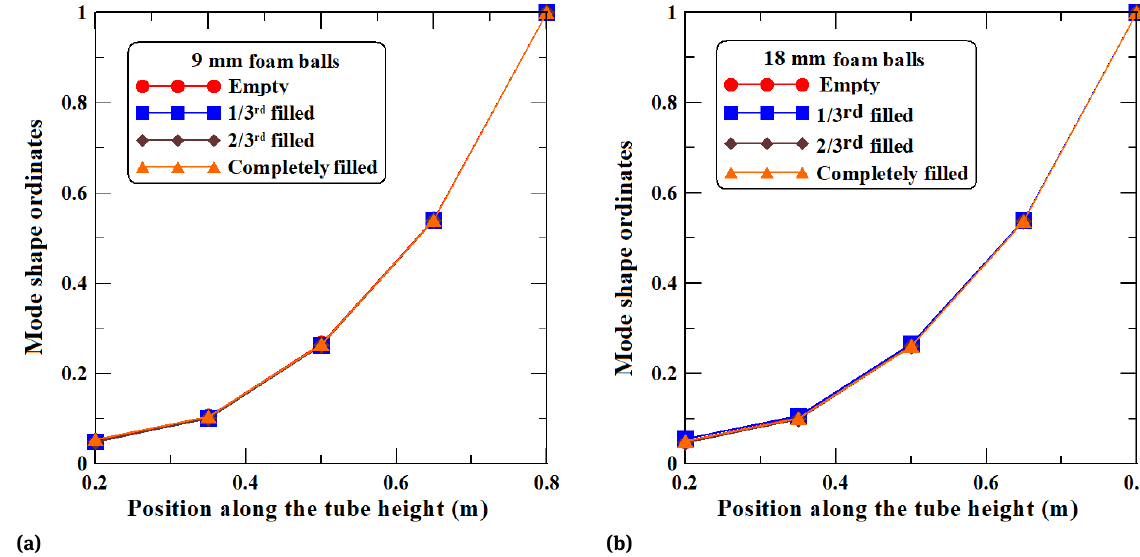
Figure 8: Fundamental mode shape of foam filled tubes with: (a) 9 mm and (b) 18 mm diameter